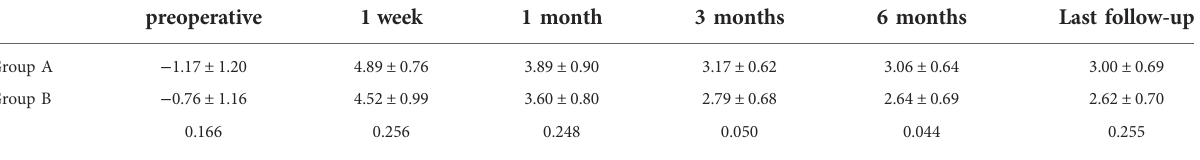
TABLE 2 MRD1 results (mm) in two groups at different follow-up